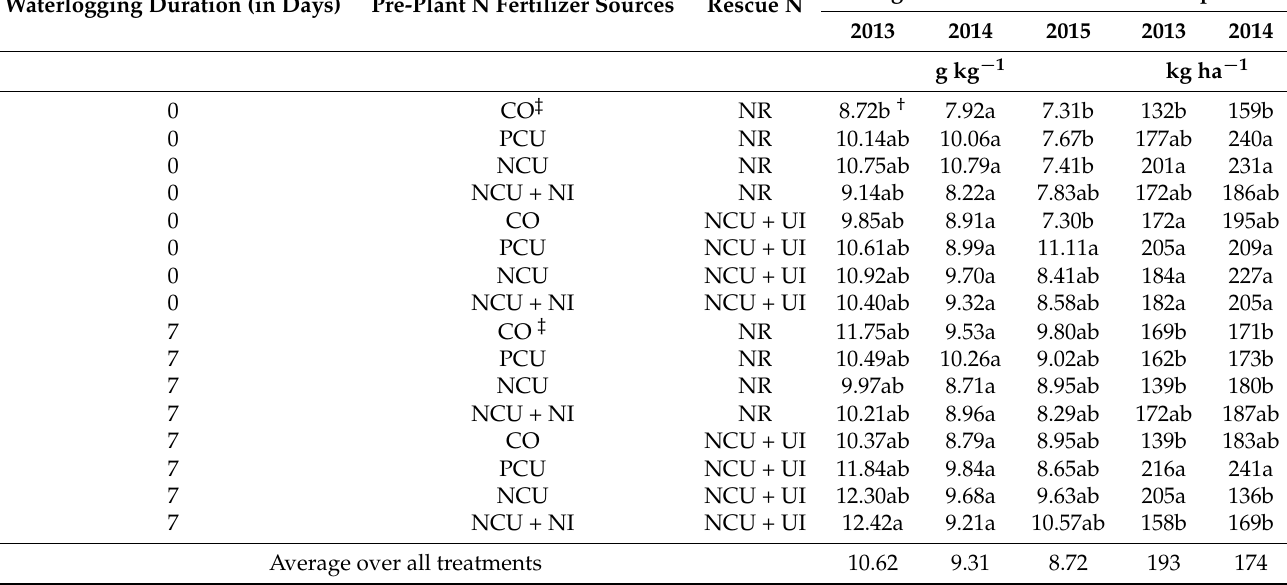
Table 6. Effects of waterlogging duration, pre-plant N fertilizer sources and rescue N application on silage N concentration, N uptake and apparent N recovery efficiency (ARE) among different growing